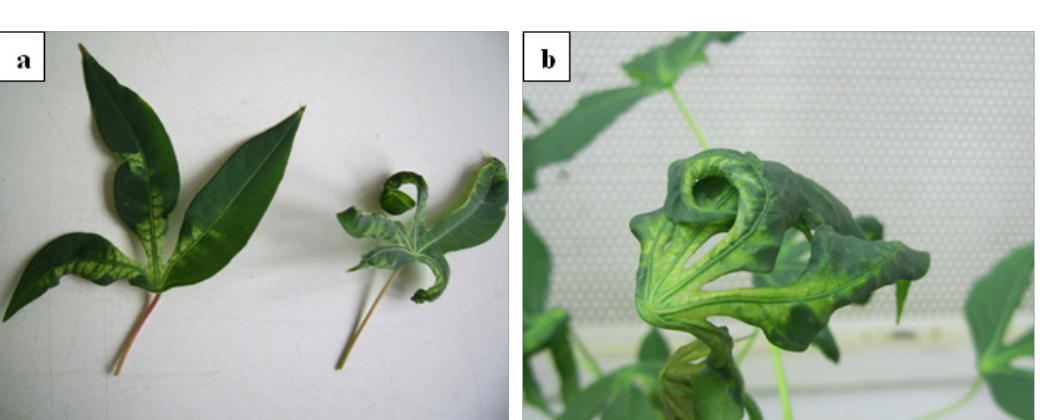
Figure 1. Symptom phenotypes of geminivirus-associated diseases caused by ( a ) African cassava mosaic virus (ACMV); ( b ) South African cassava mosaic virus -South Africa (SACMV-[ZA]); ( c ) and ( d ) Tomato curly stunt virus (ToCSV-[ZA:Ond:98]); ( e ) Sweet potato infected with a mixed infection of Sweet potato mosaic associated virus (SPMaV-[ZA:WP:2011]) and Sweet potato leaf curl Sao Paulo virus (SPLCSPV- [ZA;WP:2011]); f. Tobacco leaf curl Zimbabwe virus